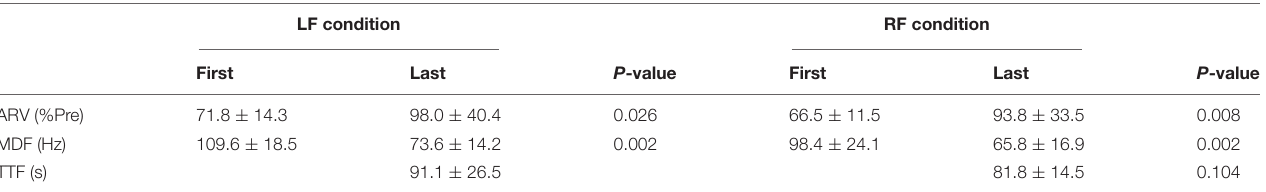
LF condition RF